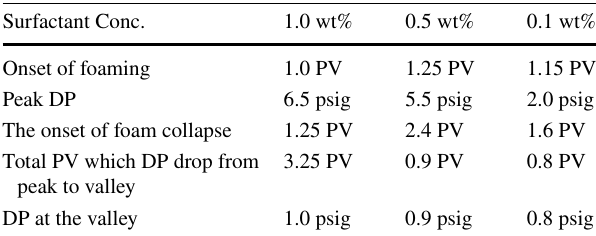
Table 8 Summary of sandpack flood result for the effect of surfactant concentration Surfactant Conc.